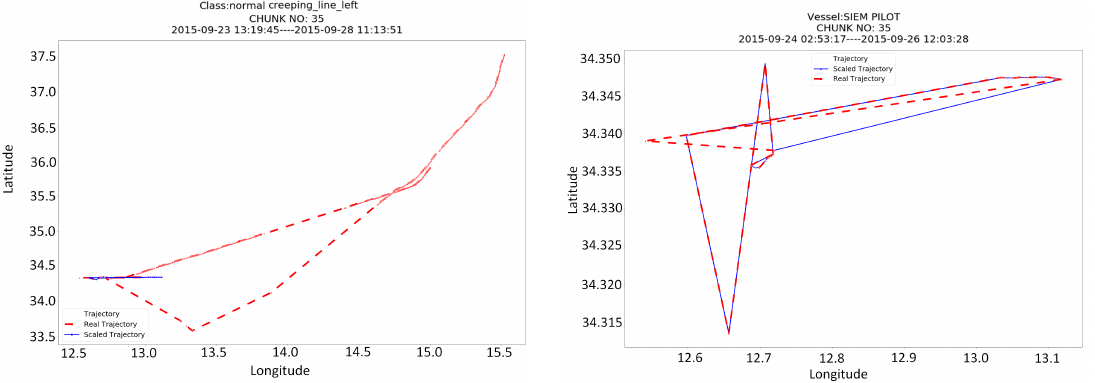
Figure 8. A creeping line pattern detected in a small section of a long trajectory ( left ) and a zoom on the selected section ( right ).